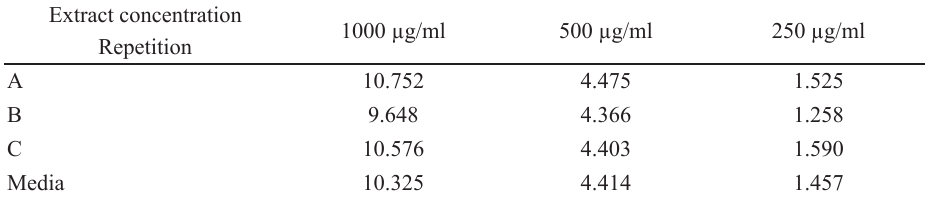
results from flavonoid content from EEstb expressed on terms of quercetin equivalent (mg of quE/g of